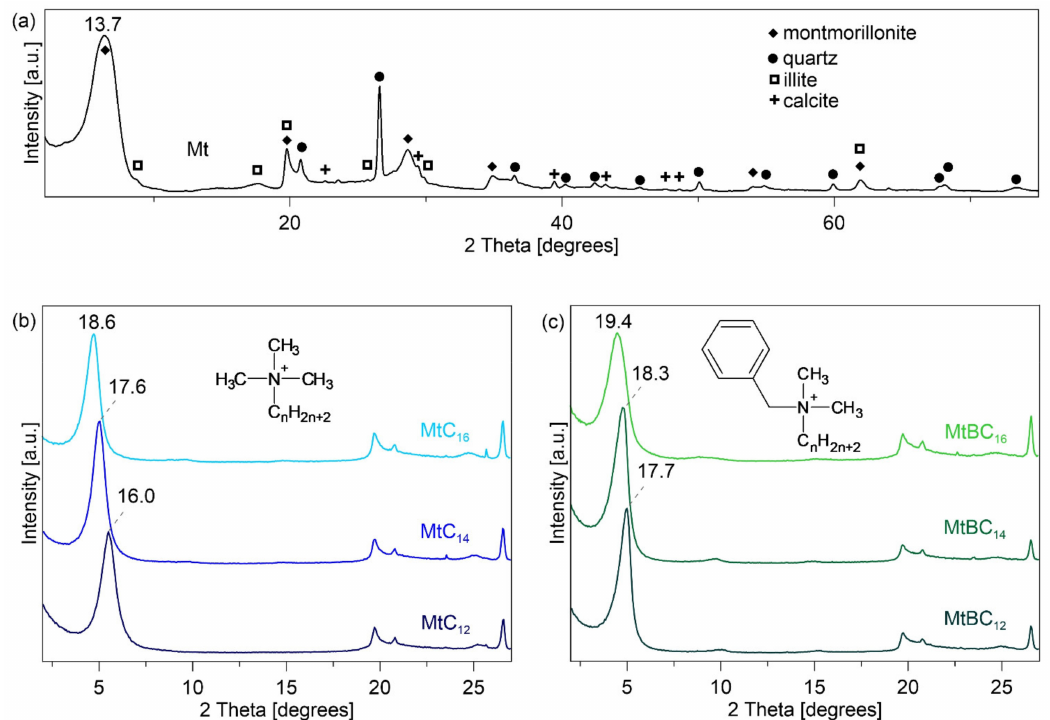
Figure 1. X-ray diffraction patterns of: ( a ) raw montmorillonite; ( b ) montmorillonite intercalated with alkyltrimethylam- monium salts; ( c ) montmorillonite intercalated with benzyldimethyltammonium salts. Structure of alkylammonium ions (n—number of carbon atoms in alkyl chain, equal to 12, 14, and